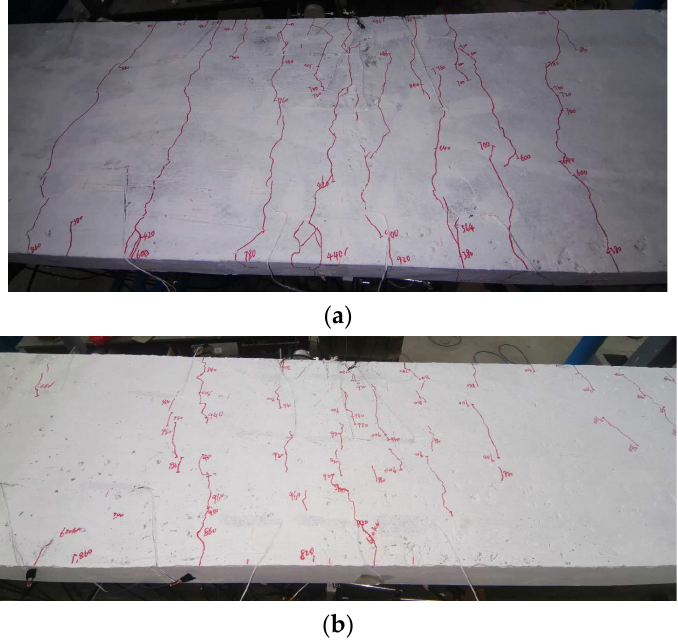
Figure 8. The crack distribution of the experimental beam. ( a ) Specimen SRB, ( b ) Specimen SPB.